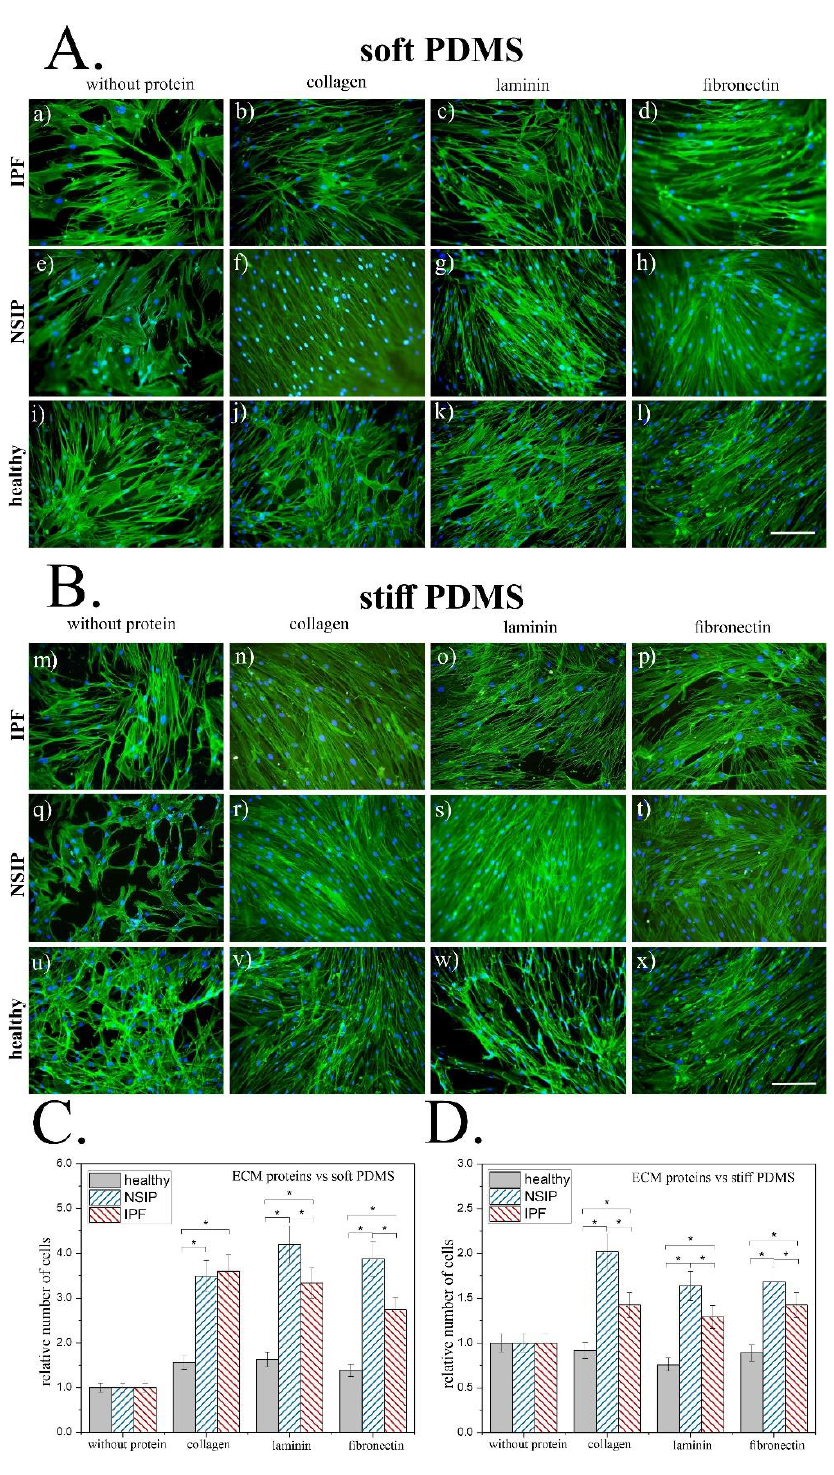
Figure 2. IPF- and NSIP-derived, as well as healthy fibroblasts cultured on two types of PDMS substrates with different treatments. ( A , B ) Fluorescence micrographs of the actin cytoskeleton (green) and nuclei (blue), recorded for IPF- ( a – d , m – p ) and NSIP-derived ( e – h , q – t ), as well as healthy fibroblasts ( i – l , u – x ) cultured on ( A ) soft and ( B ) stiff PDMS substrates covered with collagen, laminin, and fibronectin. The scale bar corresponds to 200 µ m (objective magnification 10 × ). ( C , D ) Relative number of healthy, IPF- and NSIP-derived fibroblasts cultured on ( C ) soft and ( D ) stiff PDMS substrates covered with collagen, laminin, and fibronectin. Statistical significance marked with * was achieved for p < 0.01; error bars indicate the SD ( n ≥